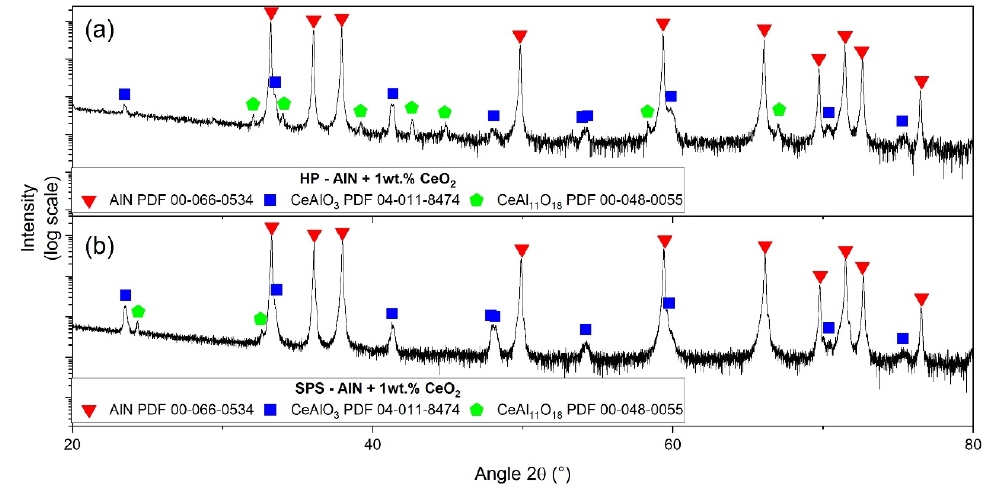
Figure 11. X-ray diffraction patterns of AlN + 1 wt.% of cerium oxide obtained by ( a ) HP and ( b ) SPS.e